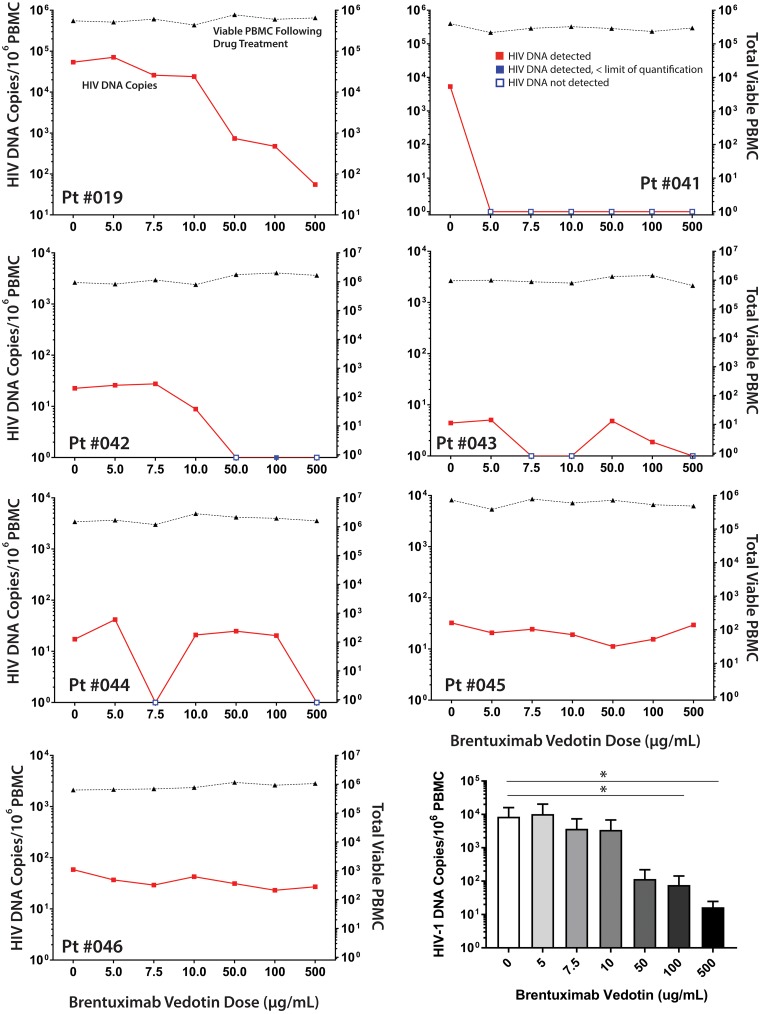
Anti-CD30 therapy reduces total HIV-1 DNA burden ex vivo.Following ex vivo culture of PBMC in the presence of antiretroviral drugs (raltegravir, 3TC) and brentuximab vedotin for 5 days, we observed a significant reduction in the mean total cell-associated HIV-1 DNA from seven ART-suppressed individuals, despite no change in viable cell numbers. Significant overall decreases were found within samples at the higher input concentrations (100μg/ml p = 0.0469, 500μg/ml p = 0.0390). Significant intergroup differences were determined using paired, nonparametric Friedman tests incorporating Dunn's tests for multiple comparisons. All experimental wells with and without brentuximab vedotin were subject to the same input cell number and culture conditions.